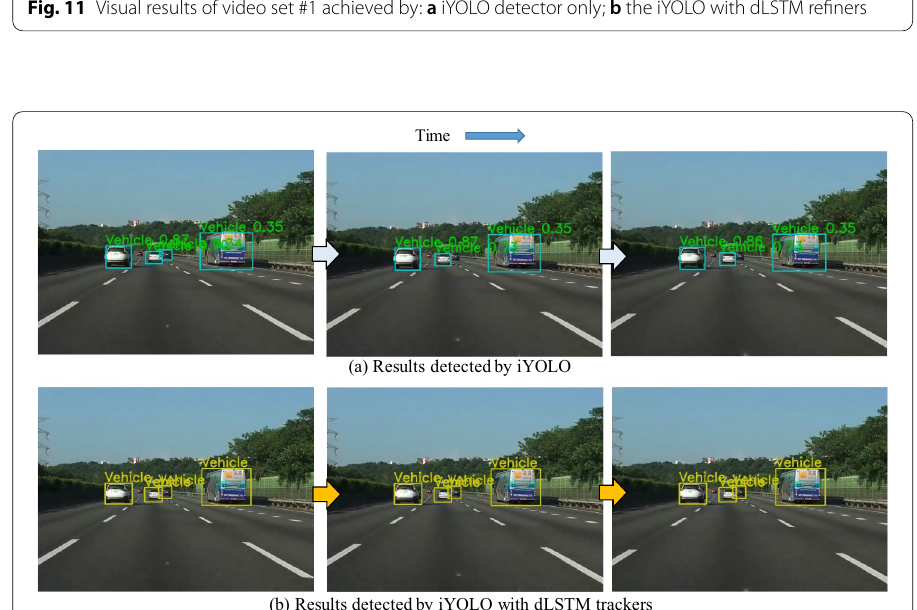
Fig. 12 Visual results of video set #2 achieved by: a iYOLO detector only; b the iYOLO with dLSTM